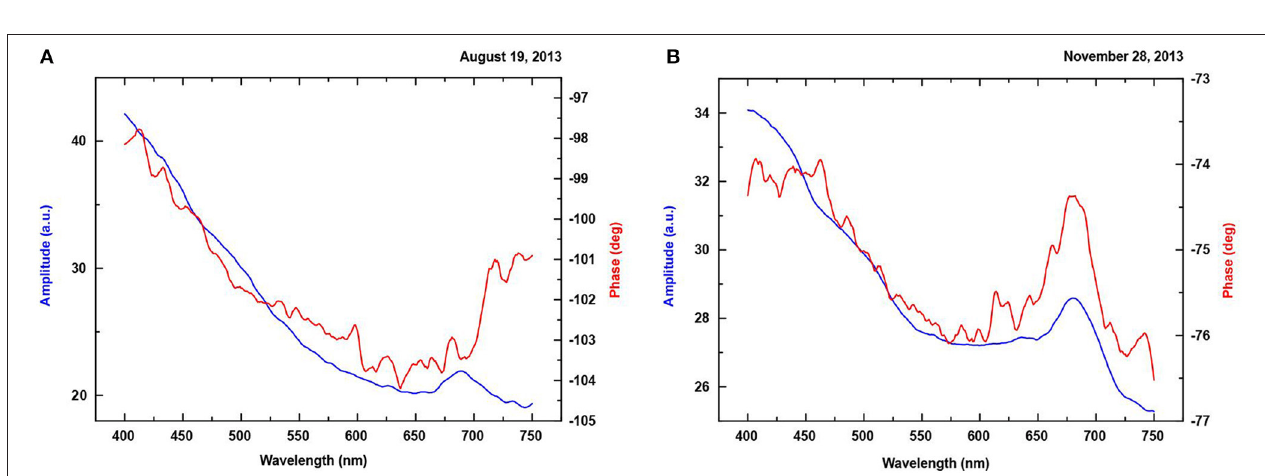
FIGURE 11 | Marine biofilm PA amplitude and phase spectra registered at the same station (Orlowo, Gulf of Gdansk, biofilm age- − 14 days, collected on glass) in different seasons: (A) summer and (B) autumn.